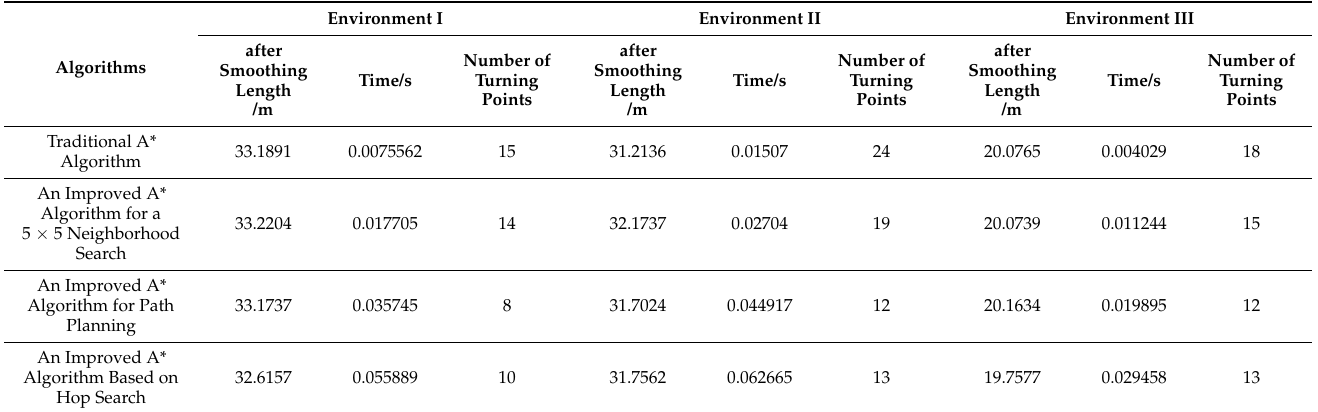
Table 2. Path Regularization Results of 4 Algorithms.